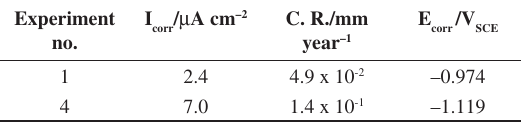
, E , C.R. , and R of the selected carbon corr corr p